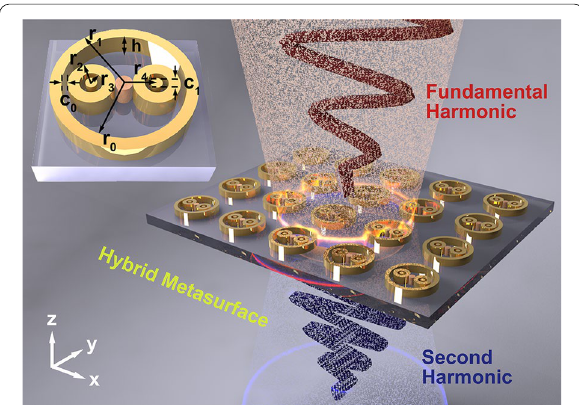
Fig. 1 Schematic view of SHG induced by hybrid metasurface with a wall ring and paired bull-eye rings. The left corner inset shows a unit cell of the metasurface with geometrical parameters of r 1 r